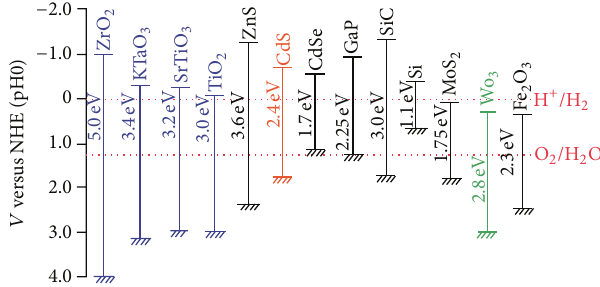
Figure 5: Band structures of TiO 2 and other popular semiconduc- tors